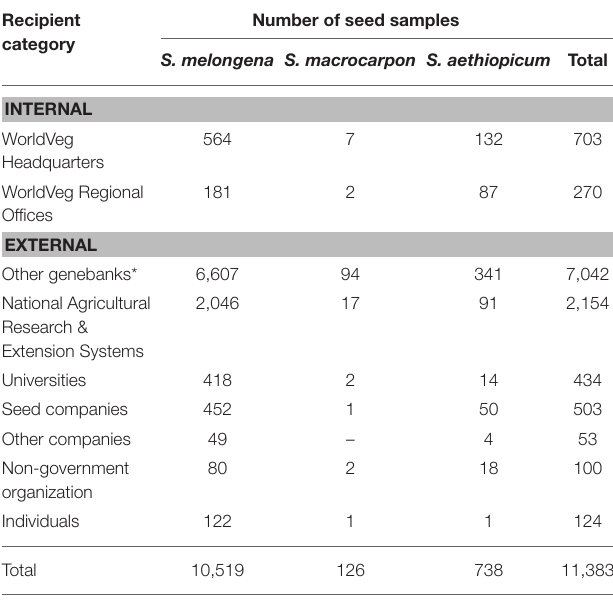
TABLE 3 | The World Vegetable Center seed distribution of cultivated eggplant by recipient category during the period